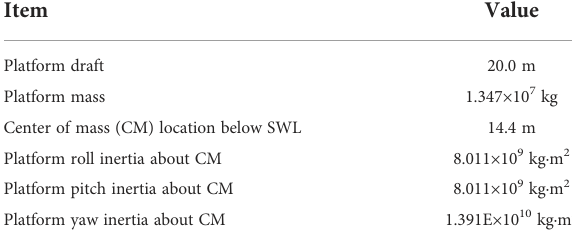
TABLE 2 Main dimensions of the semi-submersible platform.